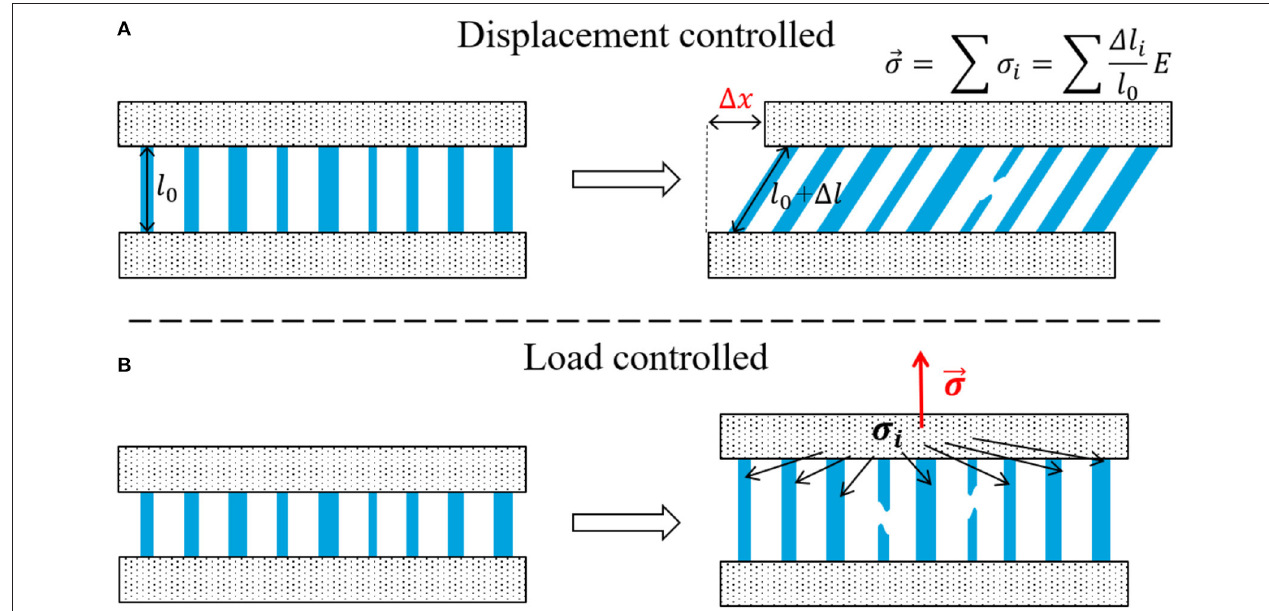
FIGURE 1 | Schematic representation of (A) displacement-controlled FBM in shear [4] and (B) load-controlled FBM in tension [5]. The fiber width illustrates the variability in fiber strength.